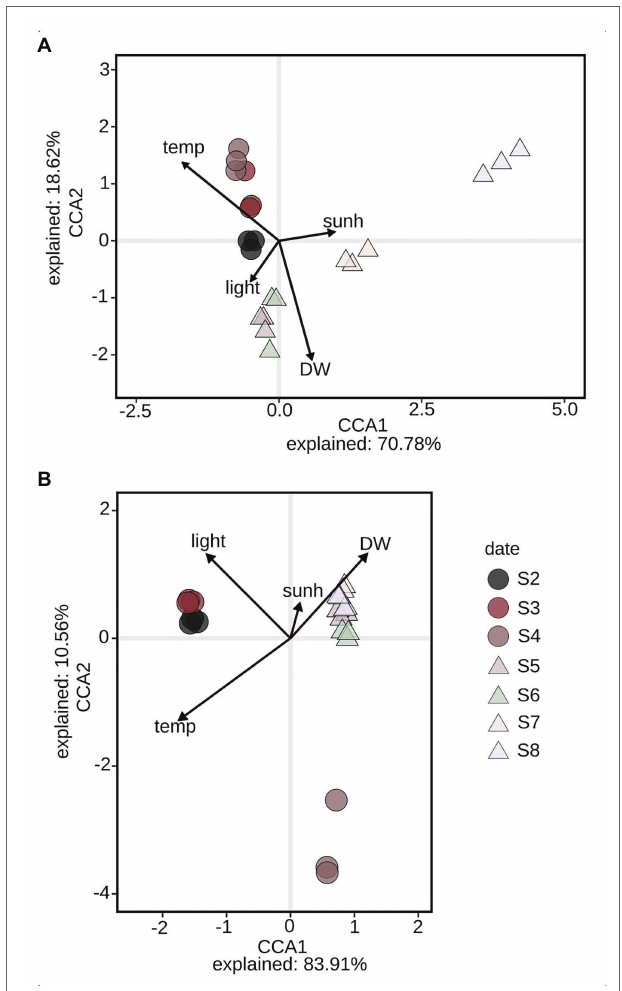
FIGURE 2 | Canonical correspondence analysis (CCA) biplot of the eukaryote (A) and prokaryote (B) community, plotting samples with independent environmental parameters at each date of sampling (S2–S8) in the reactor: Temp – temperature in PBR ( ° C), DW – biomass dry weight (gl −1 ), sunh – number of sunshine hours at day of sampling (h), light – unshaded/ shaded (reduced light input by 40–60%). Dates are denoted by color, warm period by ( ○ ), and cold period by ( △ ). Date S1 is excluded due to missing nutrient